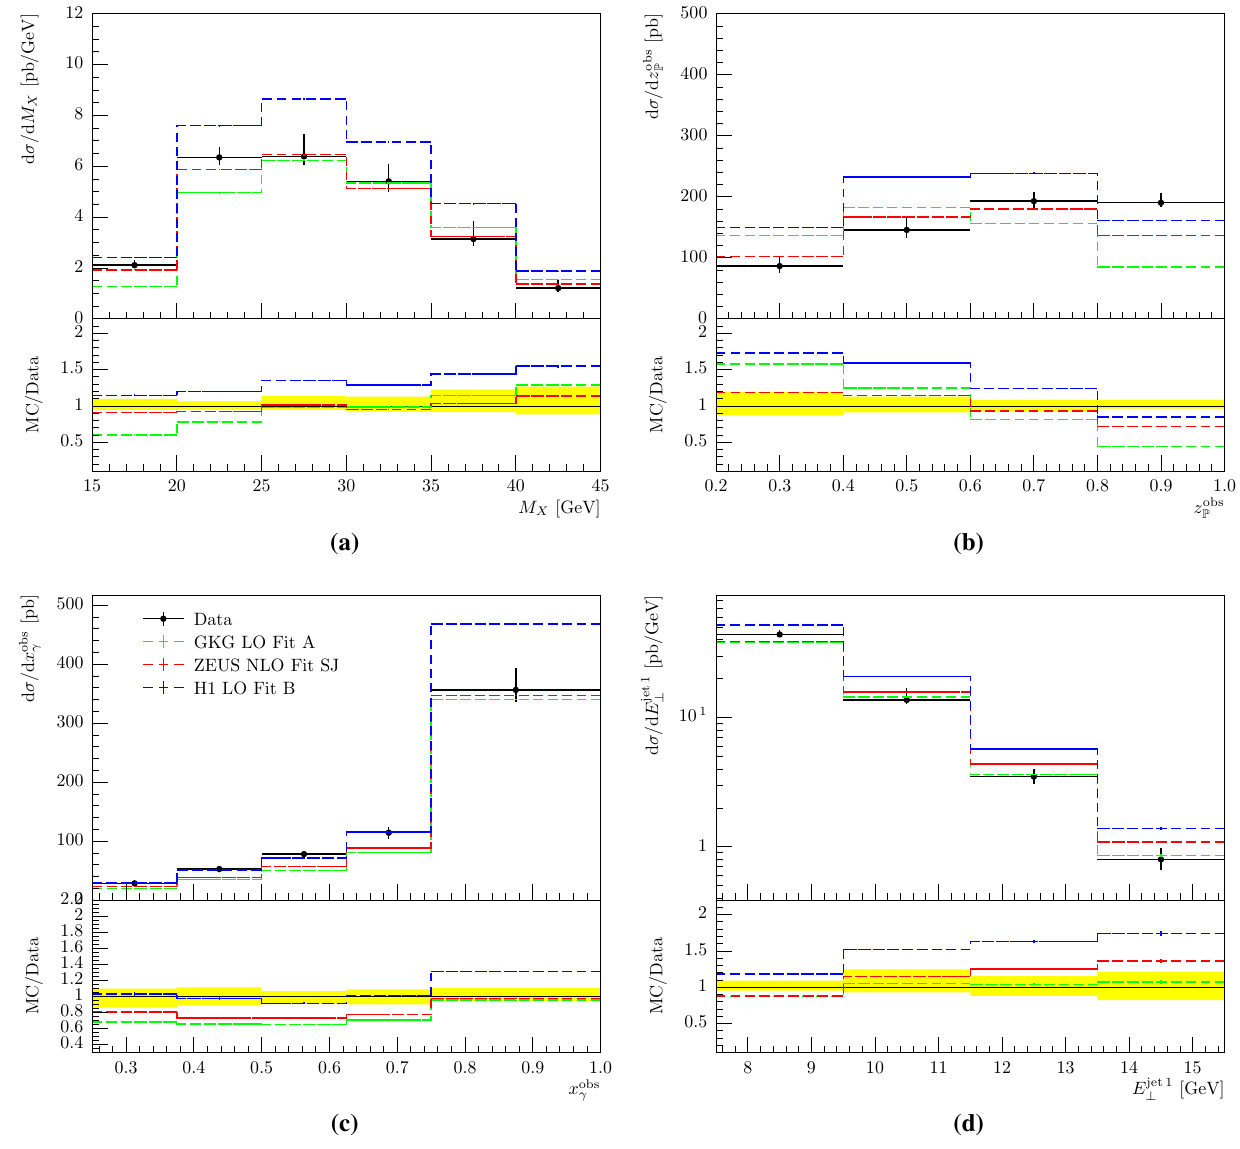
Fig. 10 The model without gap suppression using three different dPDFs: H1 LO Fit B (blue lines), GKG LO Fit A (green lines) and ZEUS NLO SJ (red lines) compared to ZEUS data on M X ( a ), z obs P ( b ), x obs γ ( c ) and E jet1 ⊥ ( d